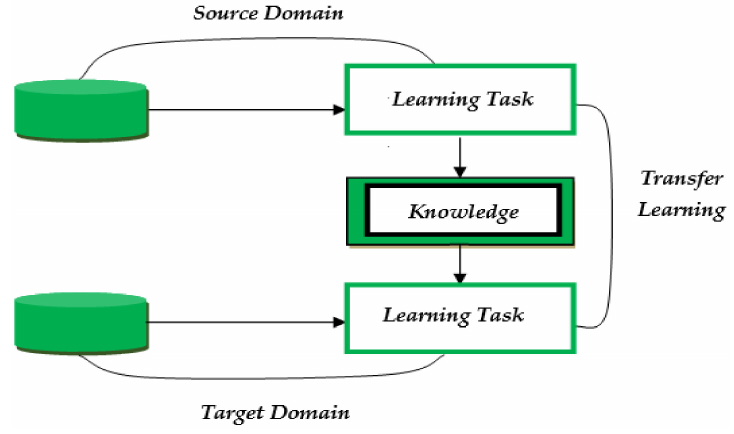
Figure 4. Transfer learning